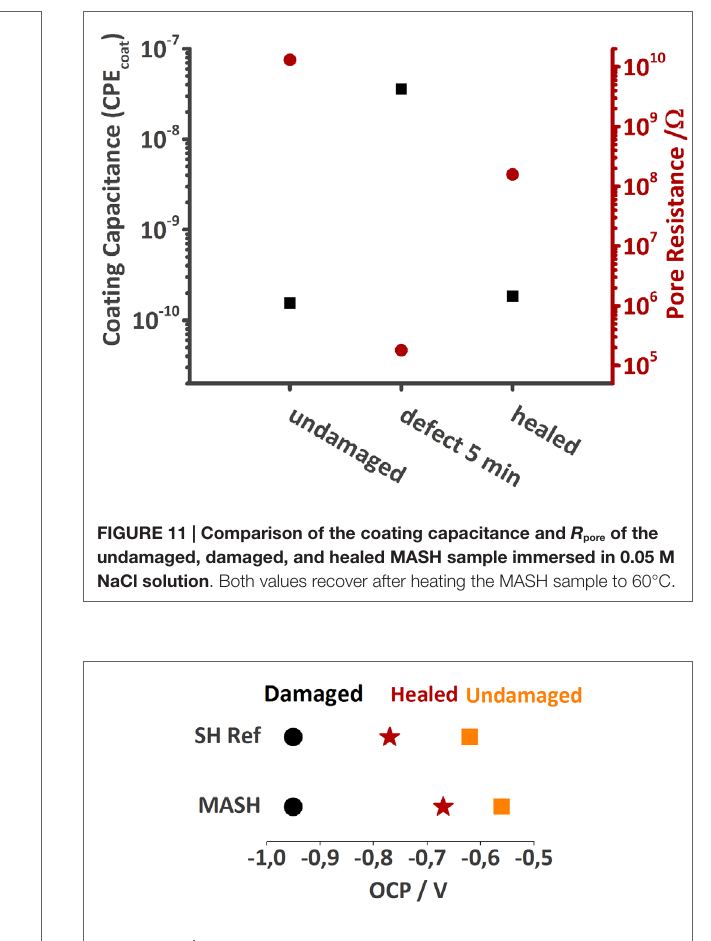
FigUre 12 | The different open circuit potentials of the samples immersed in 0.05 M nacl after equilibration against a ag|agcl reference electrode .